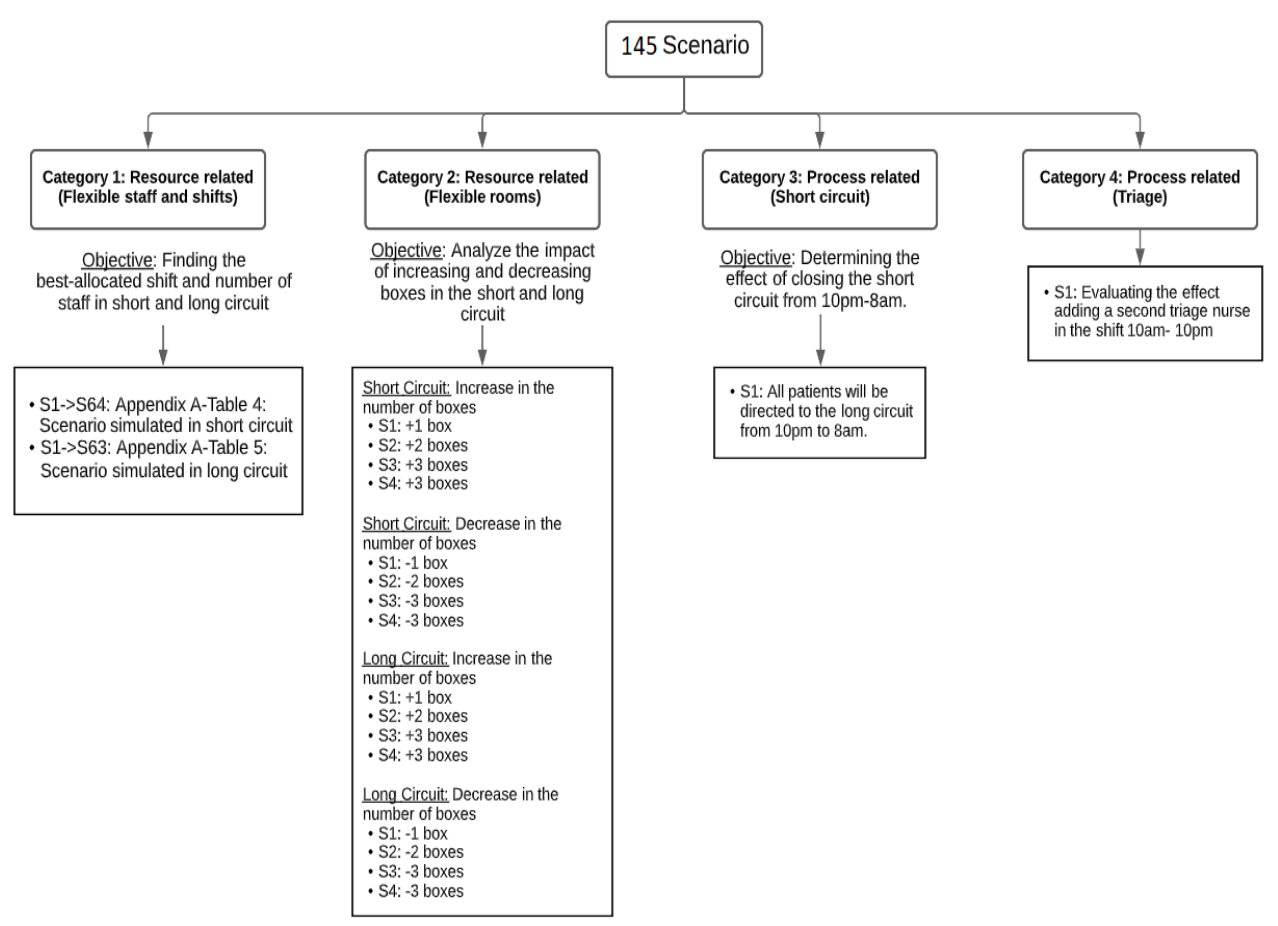
Figure 5. Categorization of simulation